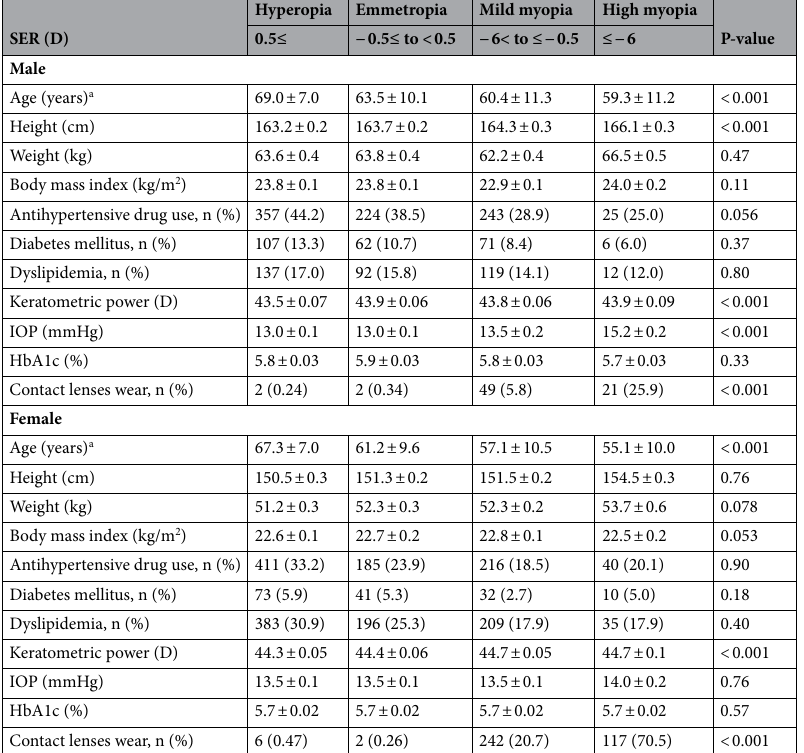
Table 2. Age adjusted sex-specific participant characteristics according to spherical equivalent refraction. Age-adjusted mean ± standard error, or age-adjusted percentages presented unless otherwise indicated. D diopter, IOP intraocular pressure, n number. a Unadjusted mean ± standard deviation.